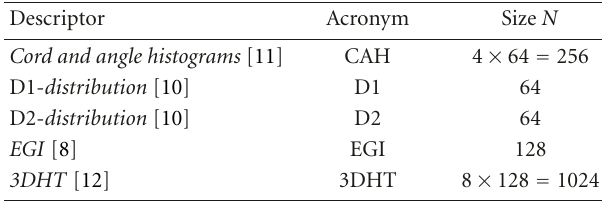
Table 3: Histogram-based 3D shape descriptors and their